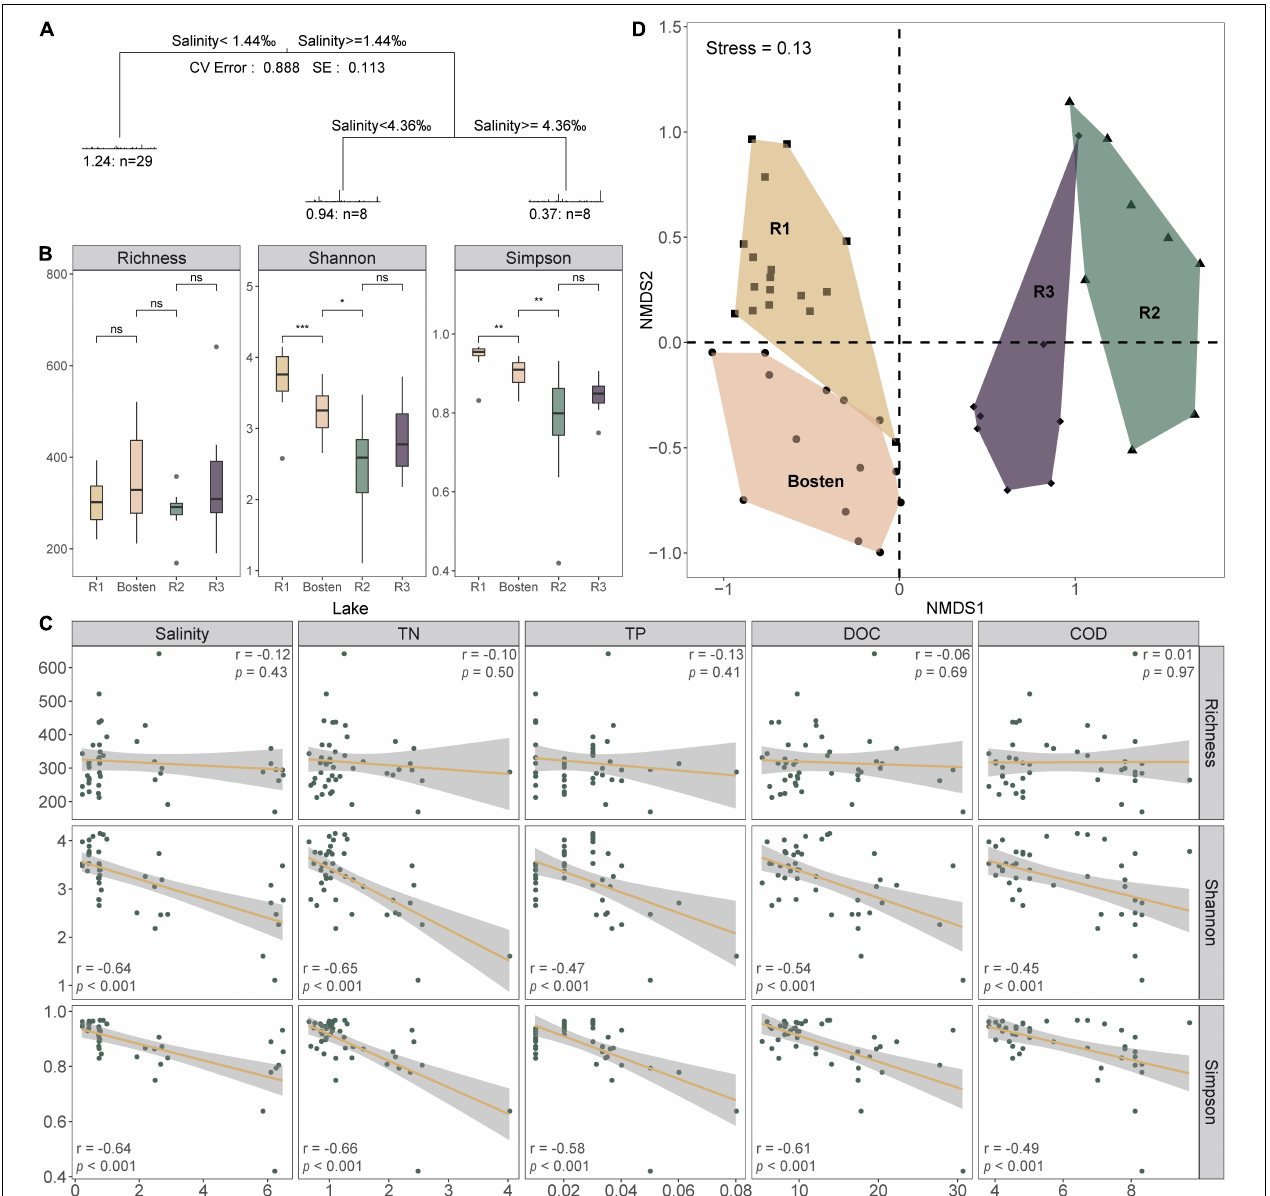
FIGURE 3 | The diversity of the bacterial communities and their driving forces. (A) Multivariate regression tree of bacterial community classification. Each leaf in the tree shows the number of bacterial communities, and drivers of their structures are specified along the branches of the tree. CV Error was calculated as the percentage of variance explained by the tree, and SE presents the standard error from 10-fold cross validation. (B) The alpha-diversity of the bacterial communities for the four lakes based on the simulated salinization and nutrient enrichment gradients. Significance levels: ns: p -value > 0.05; * p -value < 0.05; ** p -value < 0.01; *** p -value < 0.001. (C) The relationships between the alpha-diversity and main environmental variables. (D) Non-metric multidimensional scaling (NMDS) ordination of bacterial communities based on Bray-Curtis